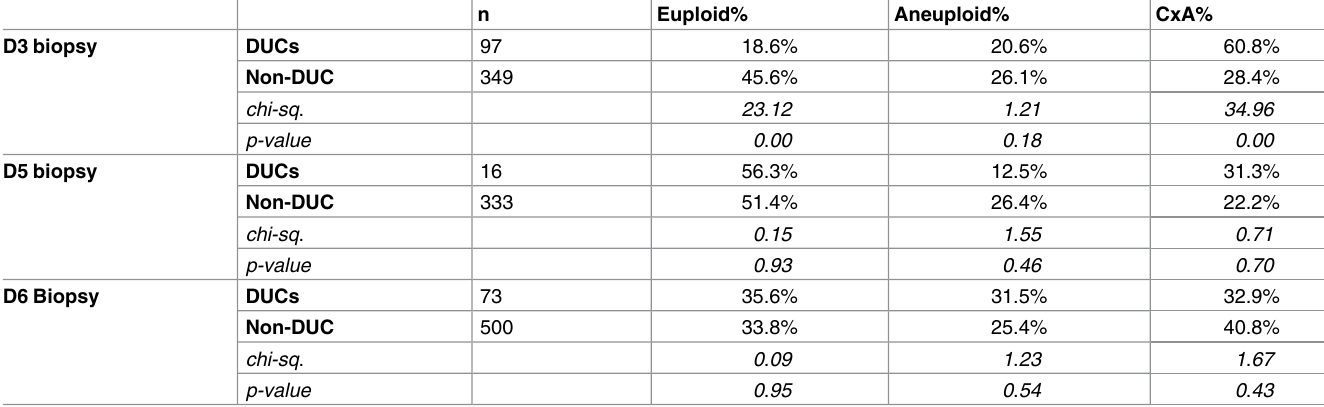
Table 5. Summaryof preimplantation genetic screen results in day 3/5/6 biopsied DUC embryos (DUCs